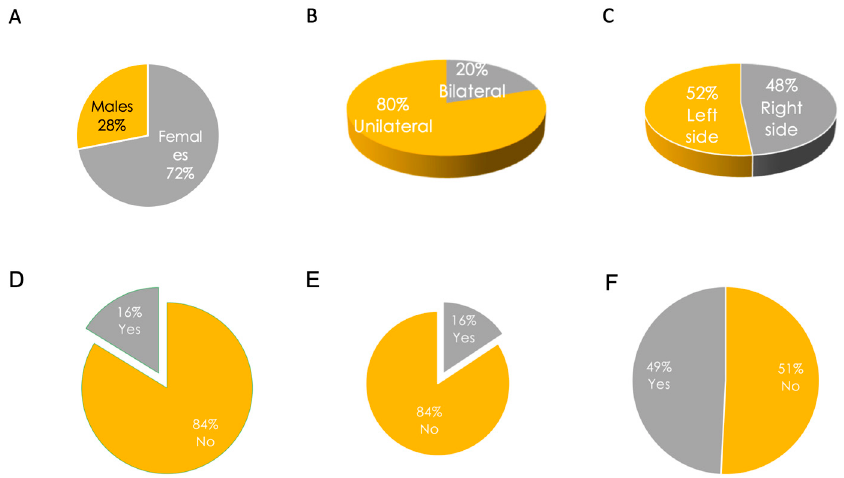
Figure 2. Characteristics of participants. ( A ) Sex of participants; ( B ) Laterality of M é ni è re’s dis- ease; ( C ) Proportion of sides ( left versus right ) when unilateral; ( D ) Percentage of participants using acoustic protheses; ( E ) Percentage of participants with accidental falls in the previous year; ( F ) Percentage of participants with comorbid headache.